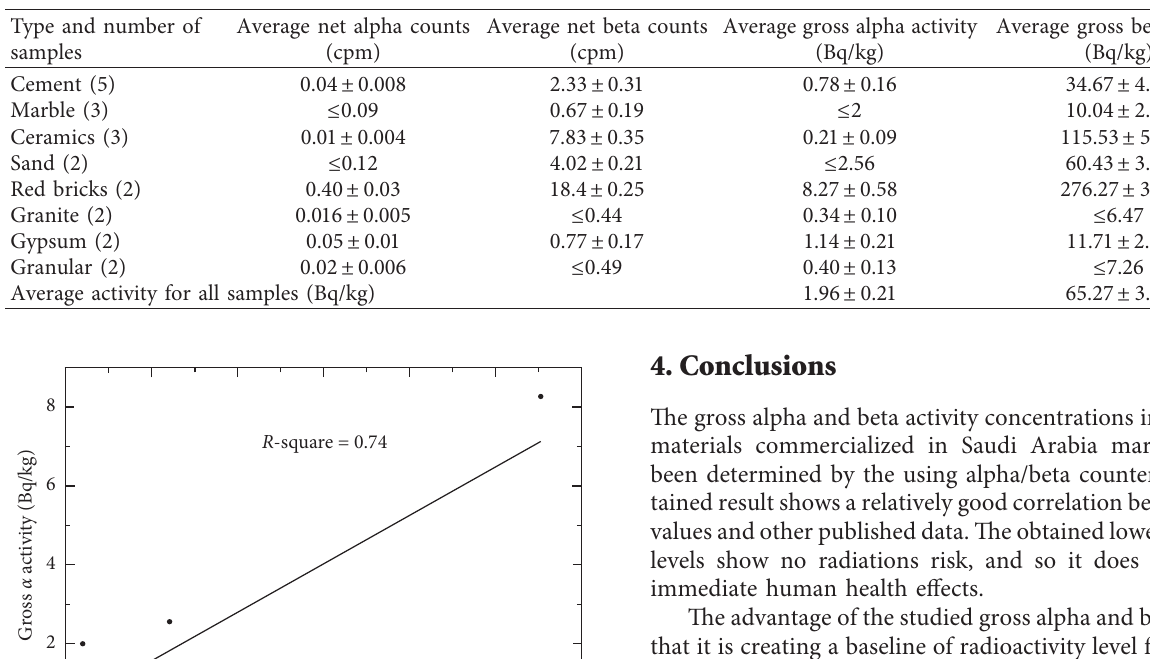
Table 1: Gross alpha/beta counts (cpm) and activities